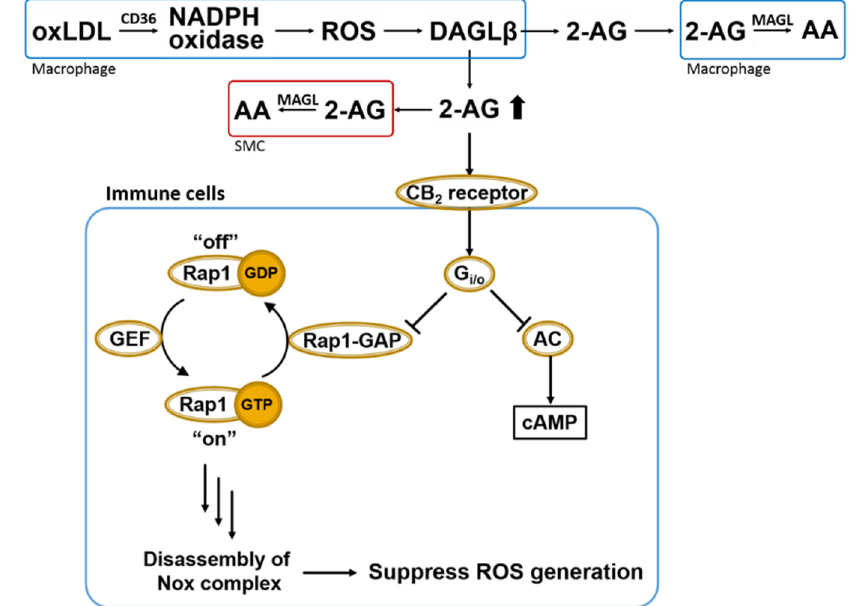
Figure 4. Overall scheme of 2AG biosynthesis/catabolism and anti-oxidative CB 2 -evoked signaling in immune cells. OxLDL-mediated NADPH oxidase (Nox) activation in macrophages leads to ROS-dependent DAGL β activation and increased biosynthesis of 2AG, which can act in either a paracrine or autocrine manner. Heightened levels of 2AG released in response to increased ROS can stimulate CB 2 receptors in a compensatory manner to suppress oxidative stress via Gi/o-mediated inactivation of Rap1-GAP (see text for details) [48]. Also shown is the canonical Gi/o-mediated inactivation of adenylate cyclase (AC). Extracellular 2AG is degraded by cells that produce it or by neighboring cells, such as smooth muscle cells (SMCs) and other macrophages. Rap1-GAP, Rap1-GTPase activating protein; GEF, GTP exchange factor; AC, adenylate cyclase; 2-AG, 2-arachidonoylglycerol; AA, arachidonic acid; MAGL, monoacylglycerol lipase; DAGL β , diacylglycerol lipase β ; SMC, smooth muscle